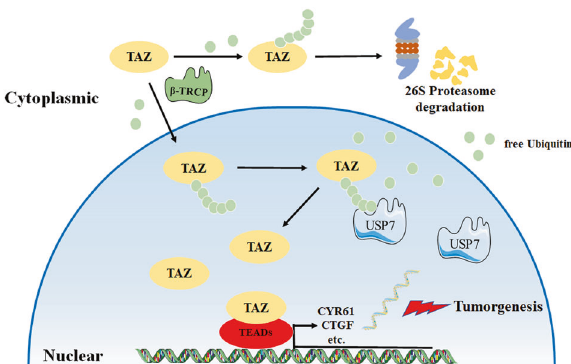
Fig. 7 Clinical signi fi cance and therapeutic potentials of USP7-TAZ axis in HNSCC. A Schematic description of experimental procedures for HNSCC PDX model. Mice bearing human tumor masses with volume over 100 mm 3 were randomly divided into two groups ( n = 6 animals per group). Animals were received P5091 (15 mg/kg) or vehicle by peritoneal injection three times per week for 2 consecutive weeks. B , C Tumor masses in the PDX model were carefully monitored at regular intervals. At Day 21 after initial injection, the masses were harvested for further analyses upon animal sacri fi ce. Final volume and weight of samples were recorded. D Representative IHC staining of TAZ and Cleaved Casepase-3 in PDX samples treated with P5091 or vehicle and their quanti fi cation data were shown. Scale bar: 100 μ m. Student ’ s t test. E The correlation between USP7 and TAZ downstream targets (CYR61/CCN1 and CTGF/CCN2) was assessed. Pearson ’ s correlation. F , G The protein expression of USP7 and TAZ in 16 primary HNSCC samples and paired non-cancerous mucosa was detected by western blot ( F ). The correlation between USP7 and TAZ was estimated by Pearson ’ s correlation ( G ). H Representative IHC staining of TAZ and USP7 in primary HNSCC samples. Scale bar: 100 μ m. I Association between TAZ and USP7 IHC staining in 99 primary HNSCC samples was estimated via Chi- squared test. J Patients with concomitant USP7 and TAZ overexpression had the worst survival rates as compared to other patient subgroups as estimated by Kaplan – Meier method and compared with Log-rank test. * p < 0.05, ** p < 0.01.